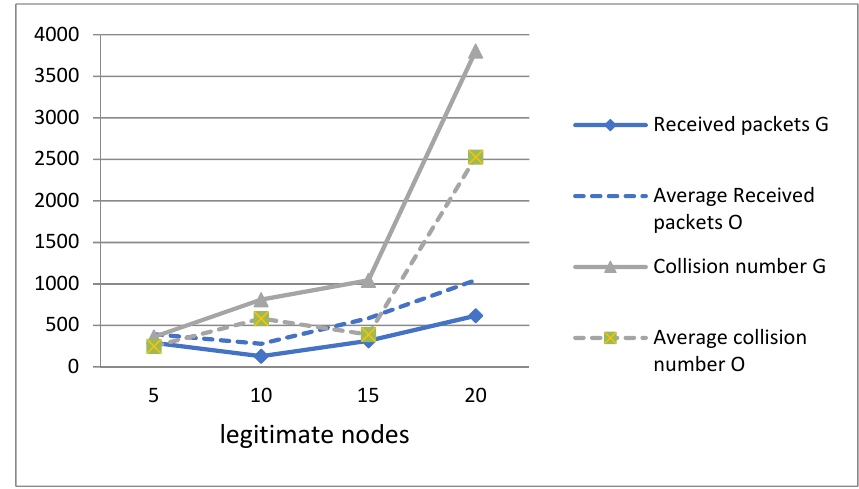
Figure 4. Received packets and collision number of legitimate and greedy nodes. In Figure 5, we have represented the two states of the radio (on, and in transmission (Tx)) of the greedy node and the other nodes of the network. Both parameters are presented in percentage. We find that in each network, the greedy node keeps its radio on longer, and performs more radio transmission than other legitimate nodes, which is normal because it sent more than the other nodes of the network. According to Figure 5, this difference in value of the two parameters is very significant between the greedy node and the legitimate nodes; this is why we have added these two parameters in the detection algorithm.